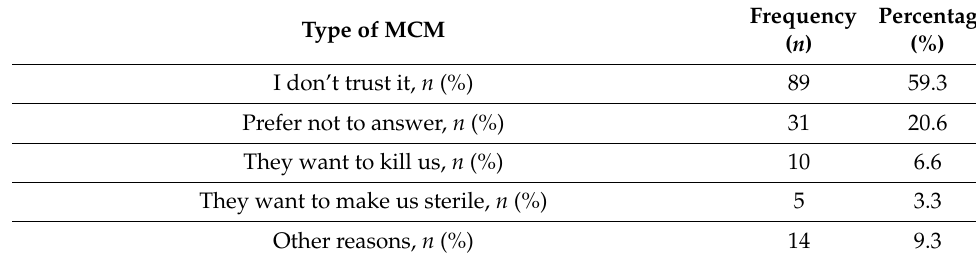
Table A2. Reasons for vaccine hesitancy among healthcare workers in the